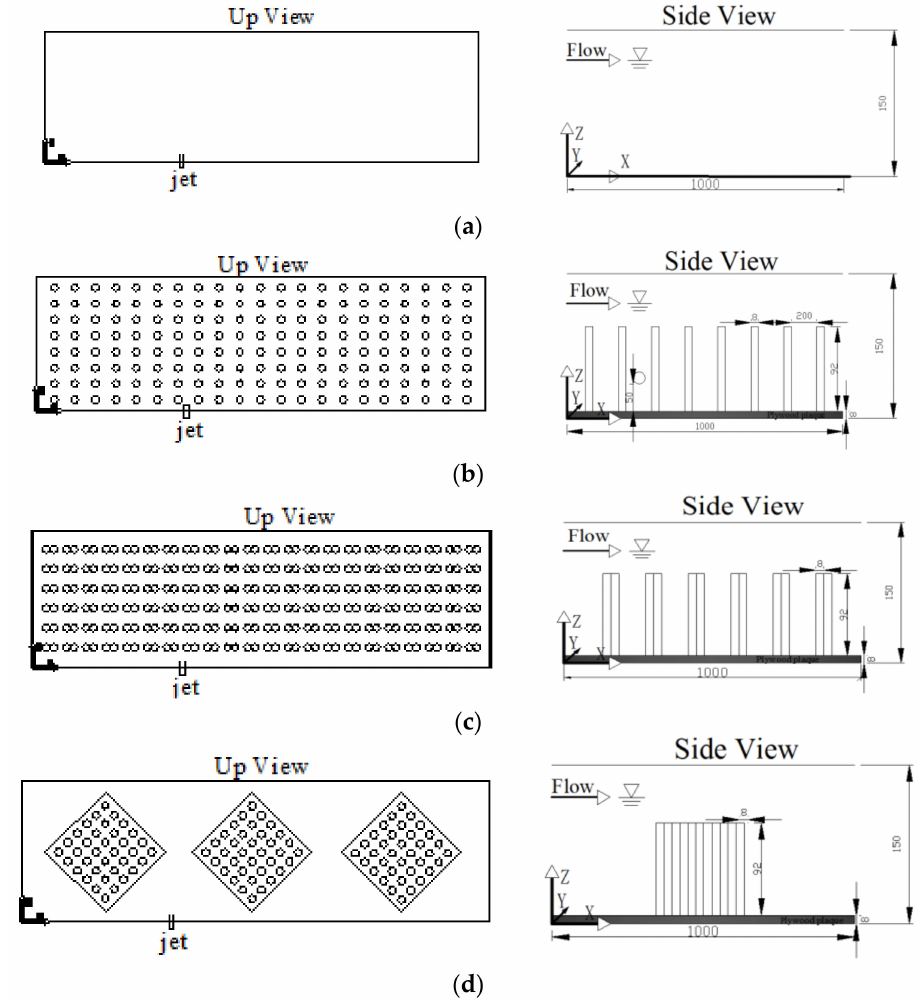
Figure 3. Schematic diagrams of the vegetation arrangement. ( a ) No vegetation arrangement; ( b ) Single row vegetation arrangement; ( c ) Double row vegetation arrangement; ( d ) Diamond vegetation